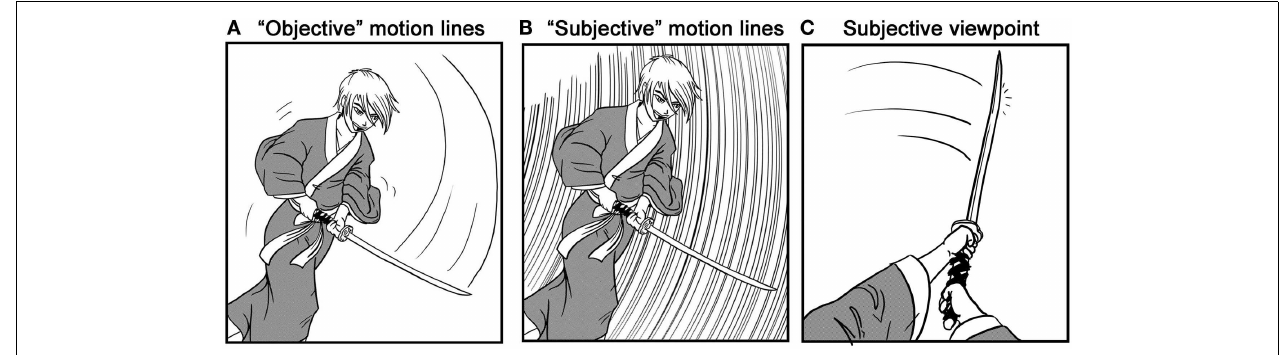
FIGURE 2 | “Objective” motion lines (A) use a line that is symbolic of the path an object travels, while “subjective” motion lines (B) “blur” the background as if the viewer were moving at the same pace as the object. In subjective viewpoints (C) the panel is shown through the perspective of a character in the